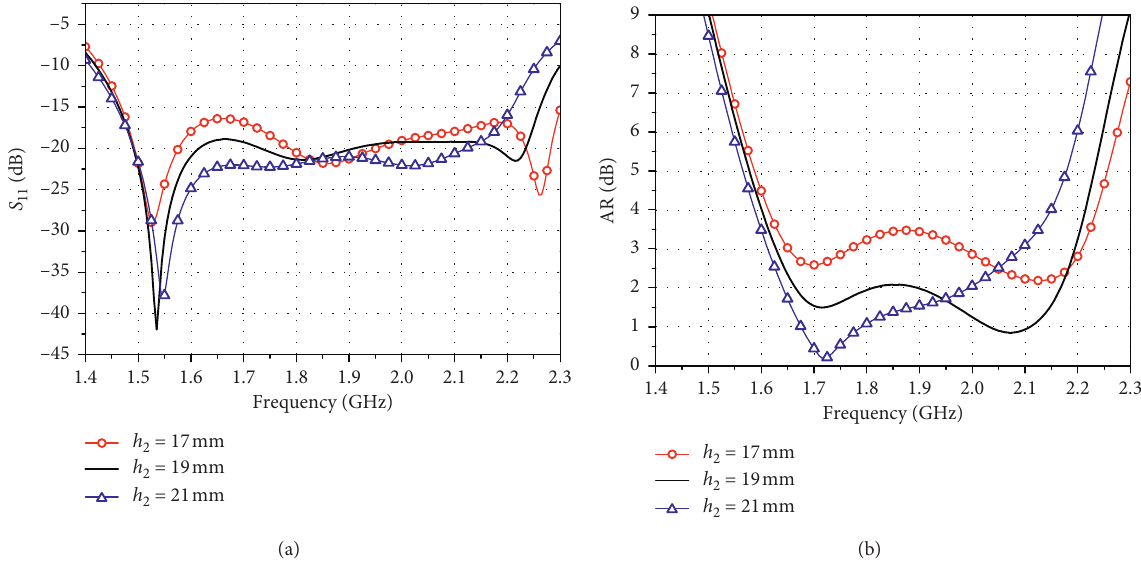
Figure 10: Effects of the height h